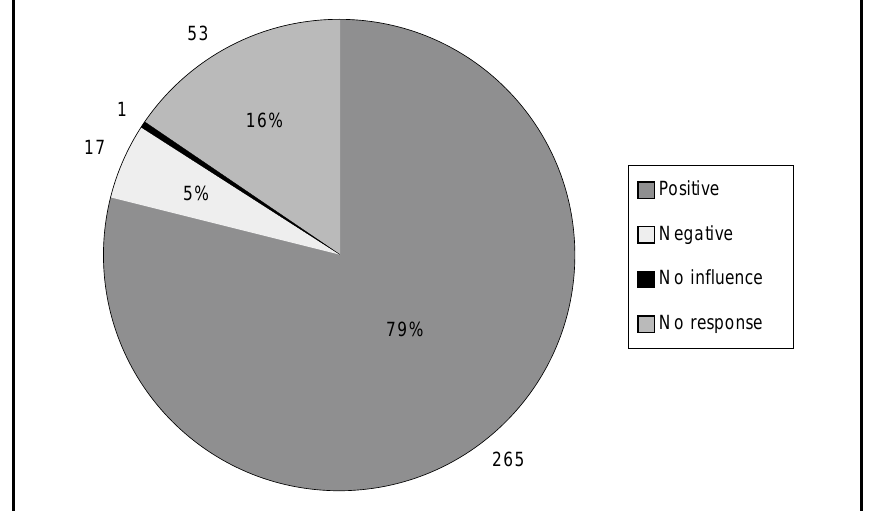
Figure 2: Physiotherapists’ perception of the effectiveness of exercise therapy as a factor in their use of it.